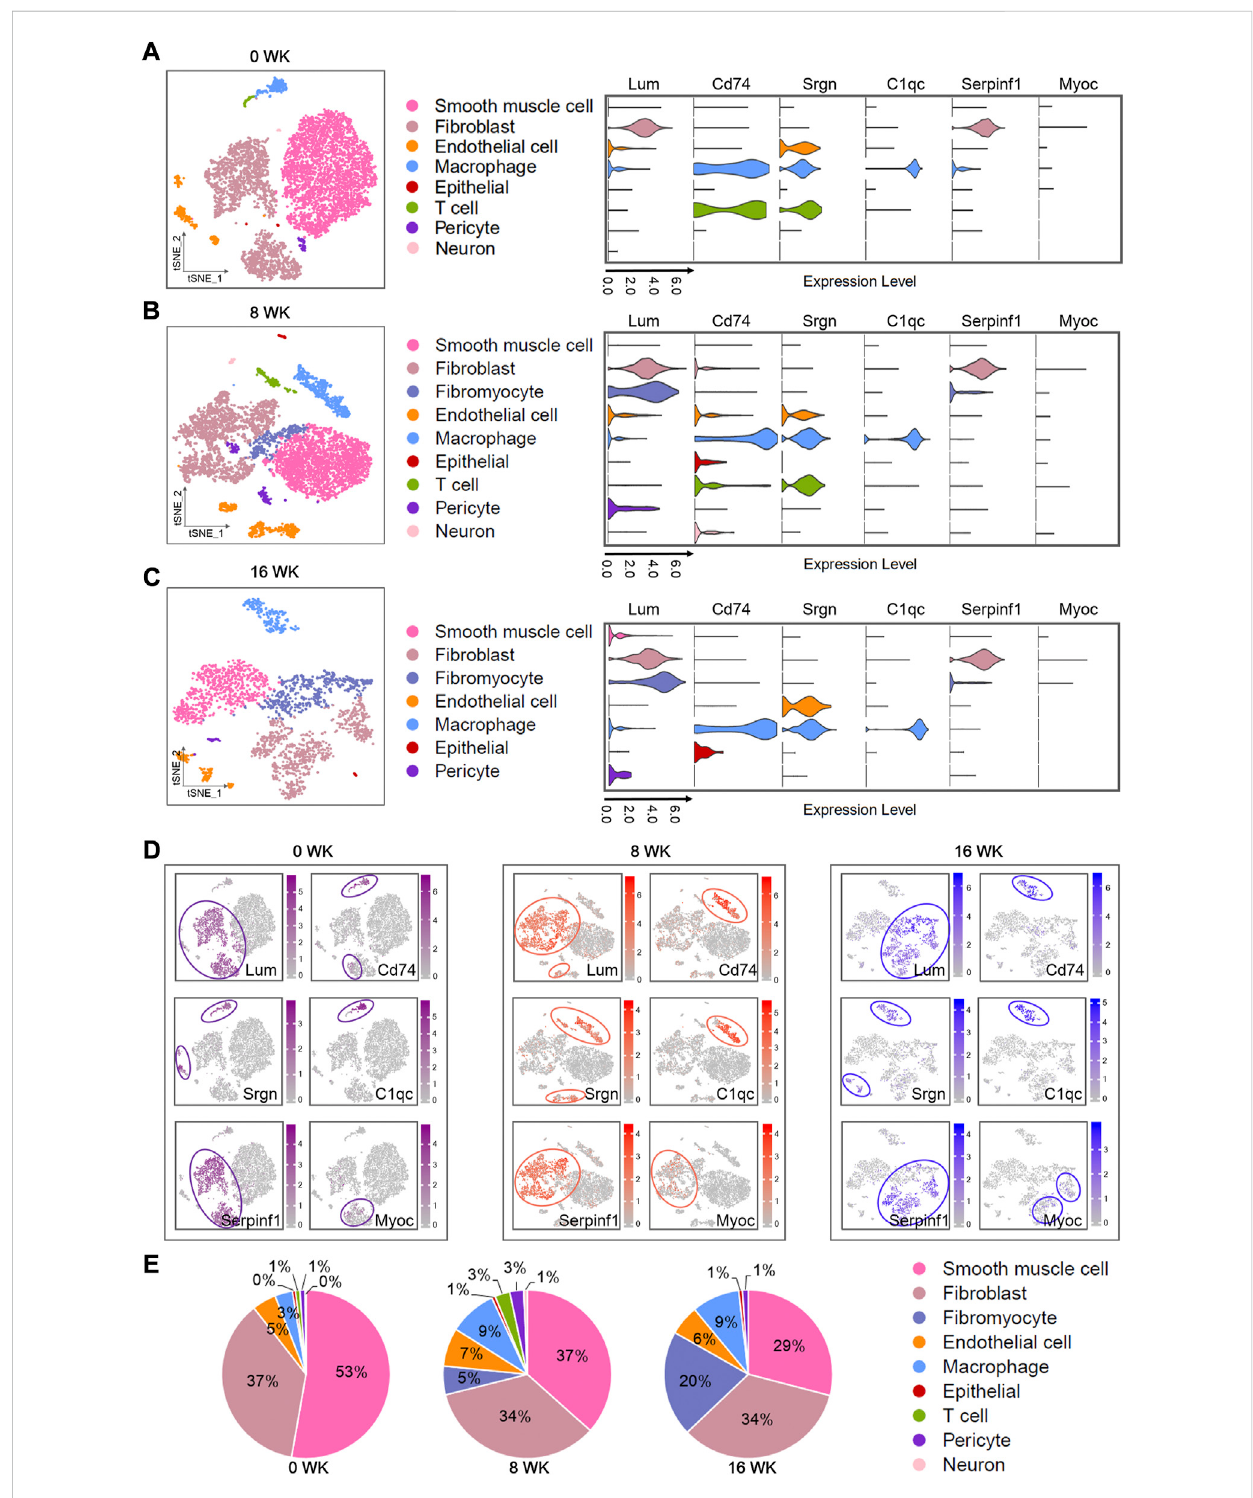
FIGURE 4 Single-cellatlas of mouse atherosclerosisarteries. (A – C) t-SNEplotsshowing differentcell types in three stages (0WK: 0-week, 8WK: 8-weeks, and 16WK: 16-weeks) by scRNA-seq. Violin plots showing loge (TPM+1) expression levels of genes. All of the expression levels are measured with the same scale. (A) t-SNE plots of 6,836 cells from four 0-week mouse artery samples. (B) t-SNE visualization of 7,326 cells from four 8-weeks mouse artery samples. (C) t-SNE plots of 2,740 cells from two 16-weeks mouse artery samples. (D) t-SNE visualization of the expression of genes. (E) Pie chart showing the proportions of cell types. The analysis data comes from GSE131776, including 0WK (non-SMC: GSM3819844, GSM3819845; SMC: GSM3819850, GSM3819851), 8WK (non-SMC: GSM3819842, GSM3819843; SMC: GSM3819848, GSM3819849), and 16WK (non-SMC: GSM3819841;